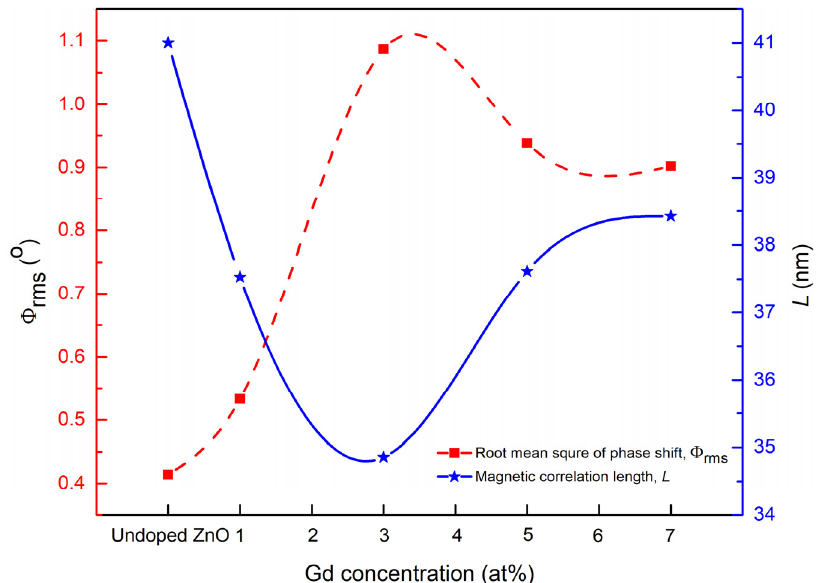
Figure 9. Correlation of root mean square of phase shift, Φ rms and magnetic correlation length, L , upon various Gd concentrations. upon various Gd